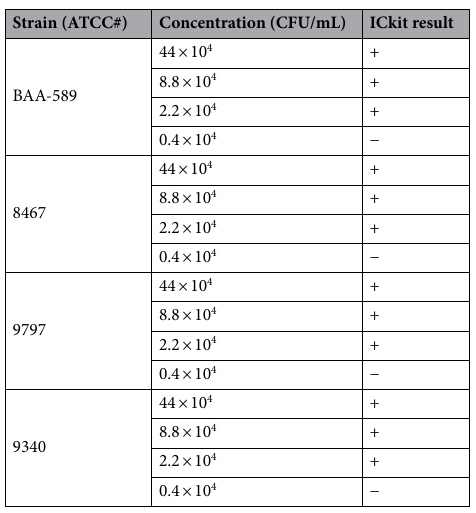
Table 1. Dilution sensitivity test with the ICkit for four different strains of Bordetella pertussis . ICkit immunochromatographic antigen kit, + ICkit-positive, − ICkit-negative.